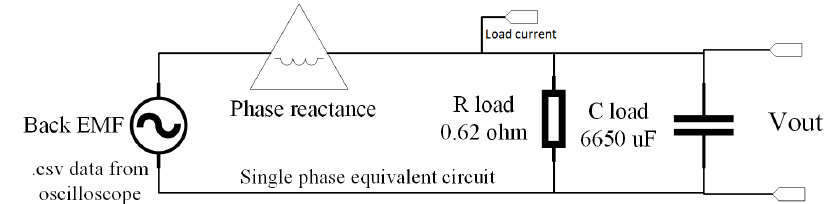
Figure 15. 4-phase TFM measured phase inductance ( a ), and resistance ( b ).